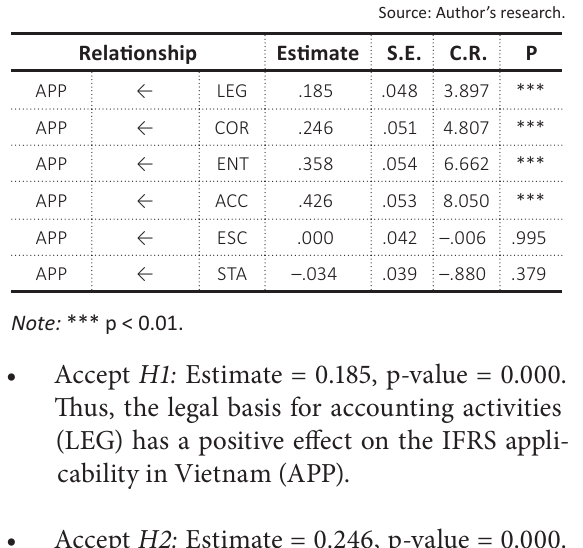
Table 7. Test results of the model hypotheses